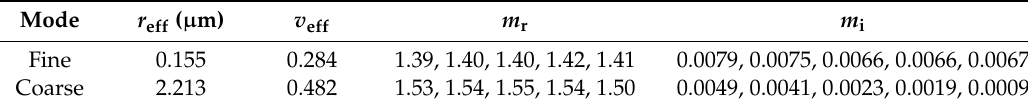
Figure 1. The relationship between aerosol spectral FMF o and FMF v . Table 2. The aerosol model parameters adopted for simulation and inversion in this